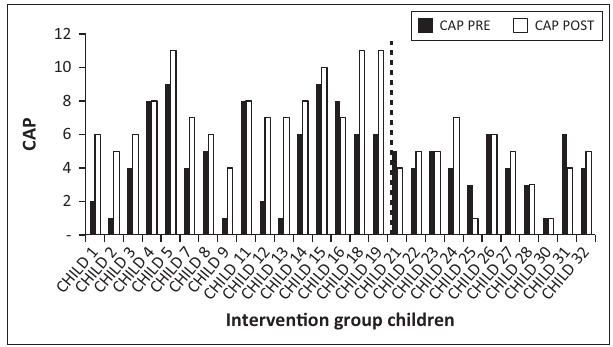
FIGURE 3: Concepts About Print (CAP) pre- and post-test results (both groups).